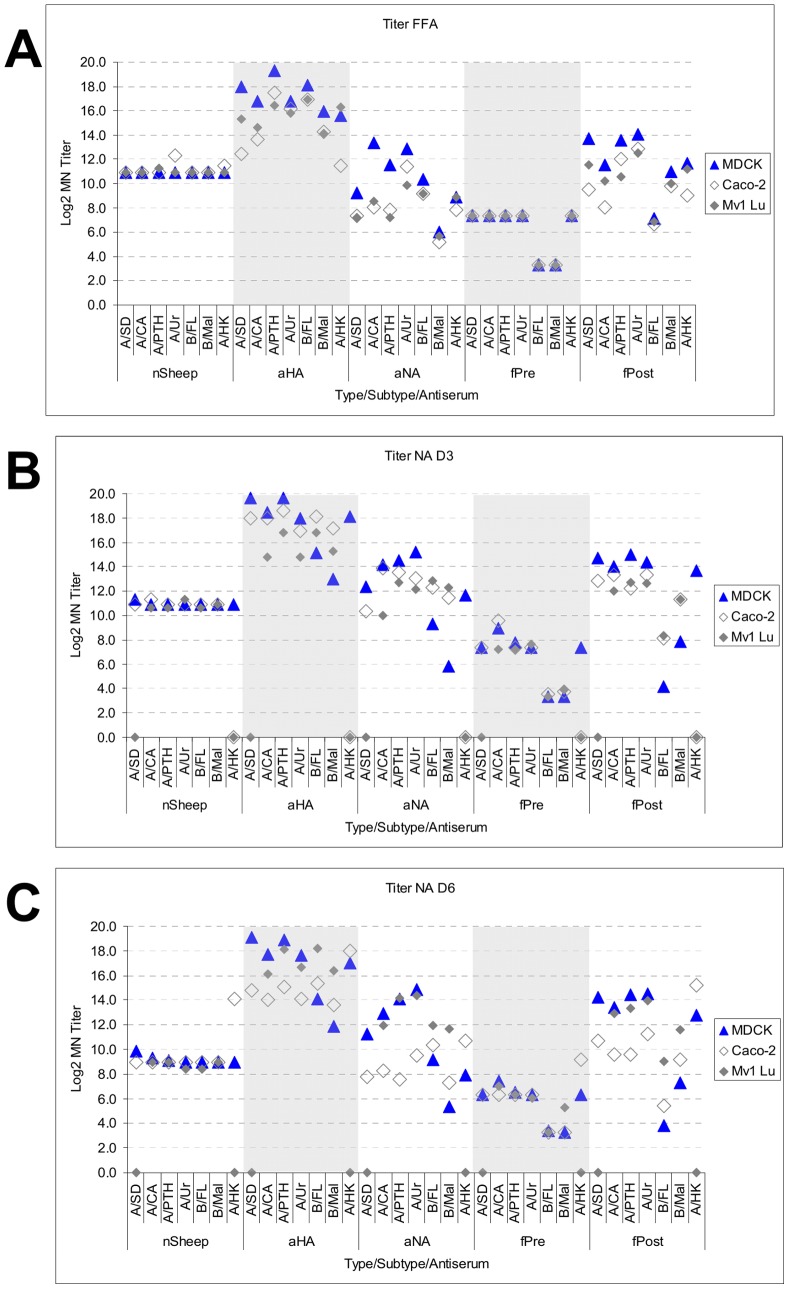
Neutralization of seven different influenza virus types and subtypes in MDCK, Caco-2, and Mv1 Lu cells (by days).Neutralization titers in MDCK (blue solid triangles), Caco-2 (gray open diamonds), and Mv1 Lu (gray solid diamonds) cells were determined by FFA at Day 1 (panel A), and NA activity at Day 3 (panel B) and Day 6 (panel C). Approximately 100 FFU of each virus type/subtype were added to serial 2-fold dilution of normal sheep antiserum (nSheep), sheep anti-HA (aHA), sheep anti-NA (aNA), or ferret polyclonal antiserum (pre- [fPre] or post-immunization [fPost] with the specified virus strain) and incubated at room temperature for 30 min. Serum treated virus was then transferred onto cells and titers were determined by NA activity. Titers were determined based on the log2 dilution that reduced the NA activity greater than or equal to 50% of that observed in virus control wells. The nSheep serum had a titer of <6.3 when assayed with minimal dilution. The titer reported in this chart is higher due to the starting dilution used in assays that was identical to the dilution used for the hyperimmune anti-HA antisera.